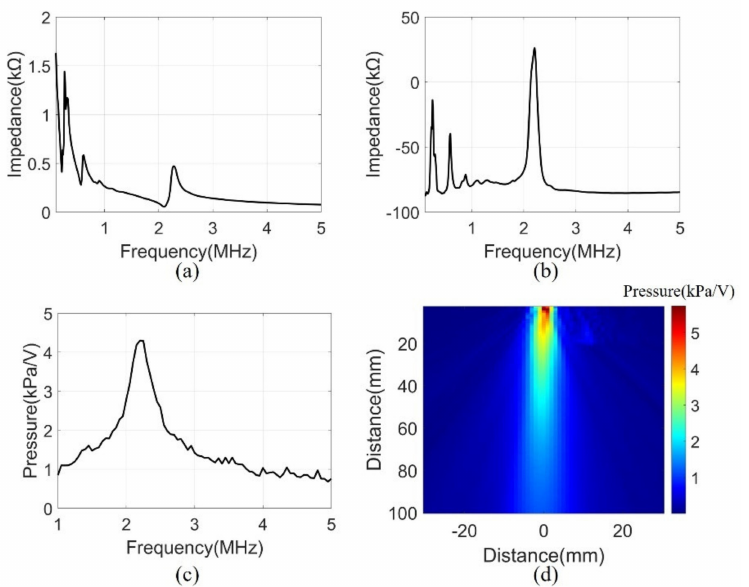
Figure 7. ( a ) Electrical impedance magnitude, ( b ) Electrical impedance phase, ( c ) Transmit sensitivity at 100 mm, ( d ) Pressure field of 2.2 MHz in